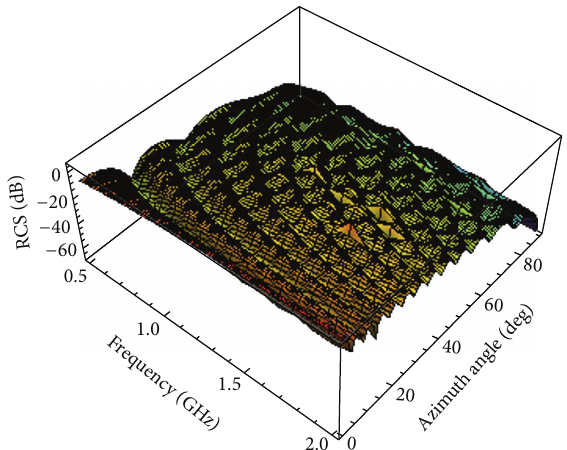
Figure 21: Backscattered RCS for a perfectly conducting triangular flat plate for 𝜃 and frequency of ̂𝑚 =